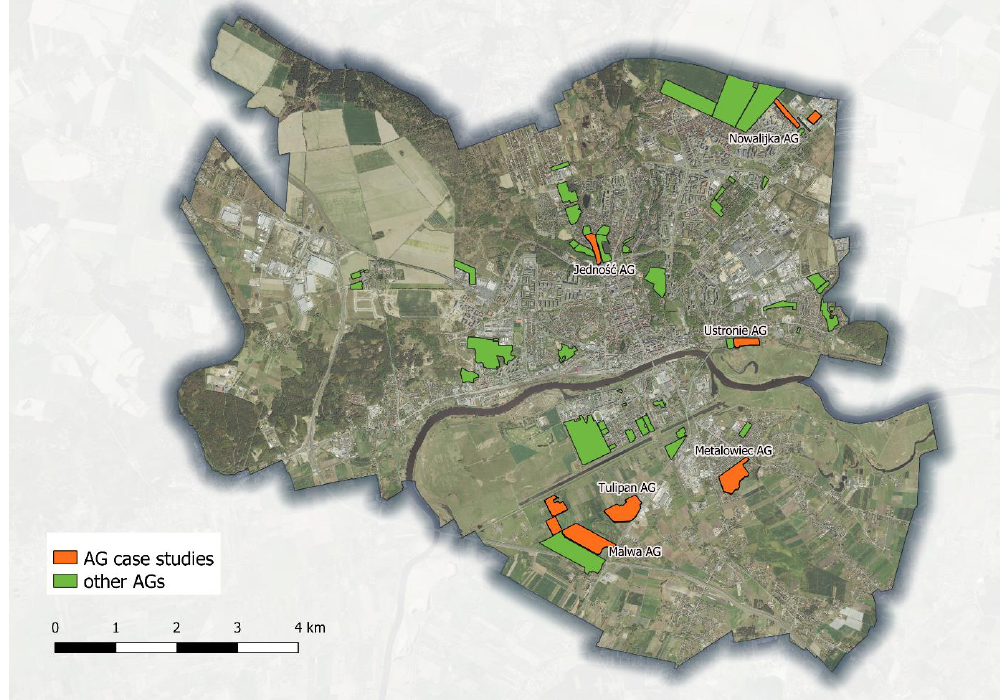
Figure 1. The location of the allotment gardens in Gorzów Wielkopolski where the quality of soil and plant material was tested.